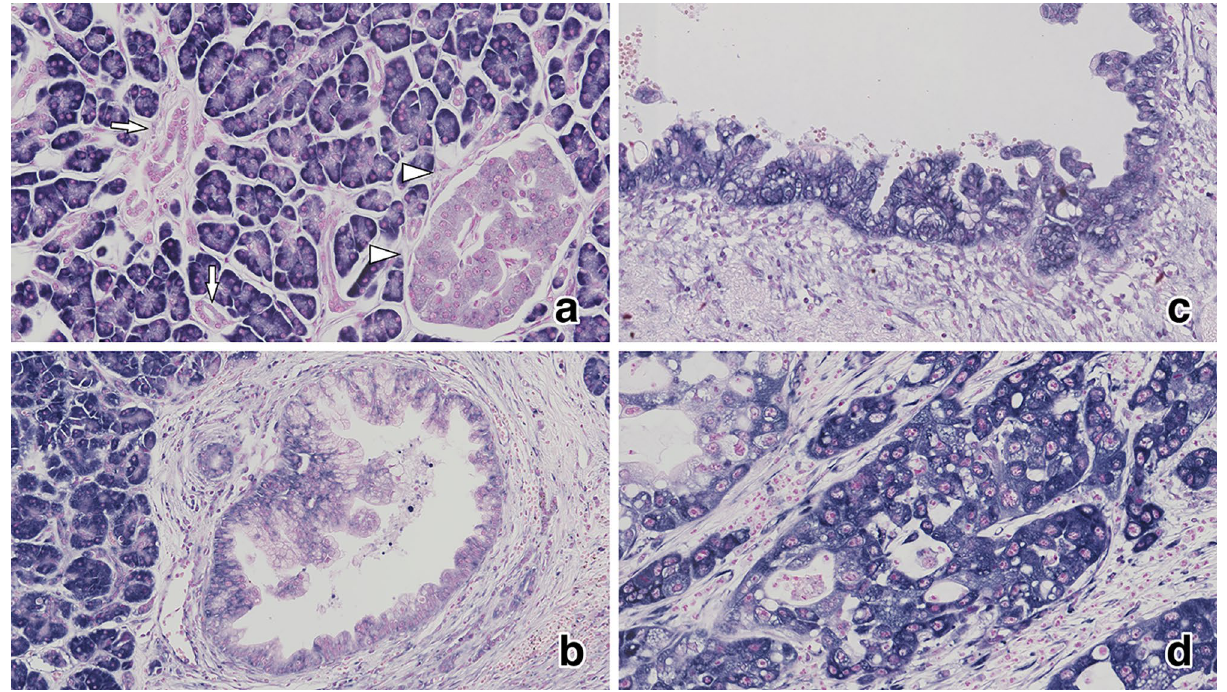
Figure 1. In situ miR-4653-3p hybridization. Normal pancreatic tissue showed that acinar cells were diffusely and strongly positive for miR-4653-3p expression, while pancreatic ducts (arrow) and islet cells (arrowhead) were negative and weakly positive for miR-4653-3p expression, respectively ( a ). Low-grade pancreatic intraepithelial neoplasms (PanINs) were weakly and focally positive for miR-4653-3p expression ( b ). High- grade PanINs ( c ) and pancreatic ductal adenocarcinomas ( d ) were diffusely and strongly positive for miR- 4653-3p